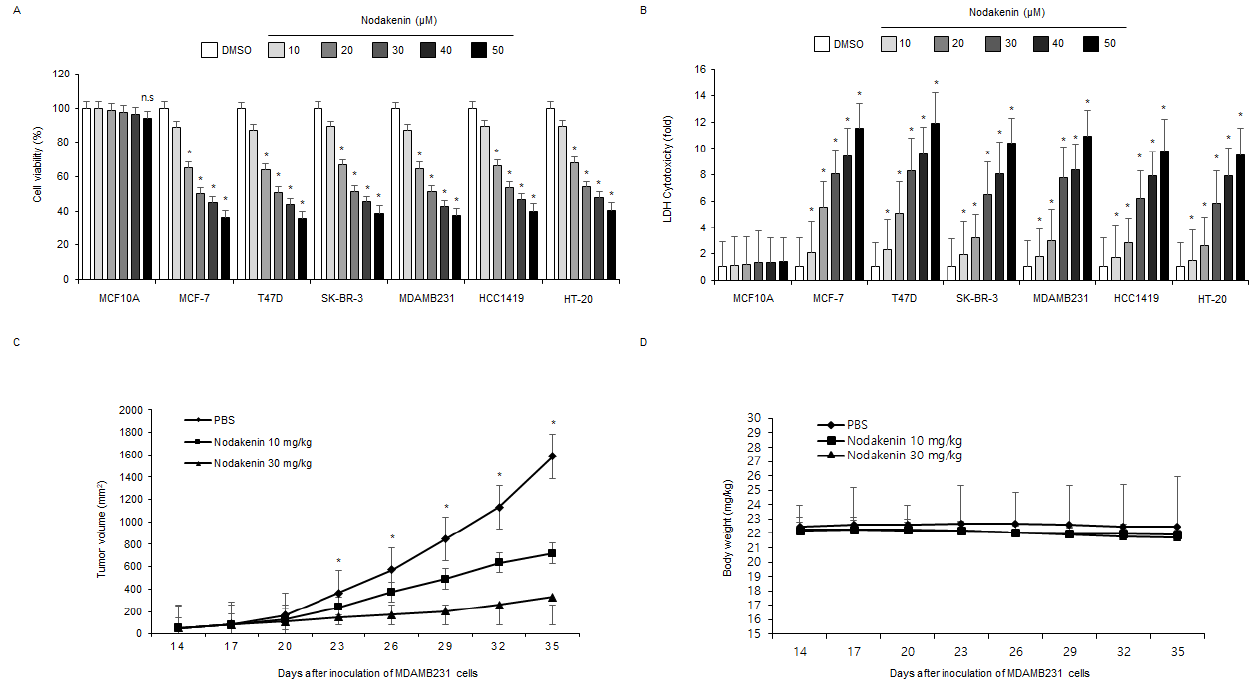
Figure 1. Anti-tumor effects of nodakenin in various breast cancer cell types and xenograft models. ( A , B ) Cell viability and LDH cytotoxicity were determined using the WST-1 assay and LDH cyto- toxicity assay in a dose-dependent manner in nodakenin-induced normal breast and breast cancer cells (MCF10A, MCF-7, T47D, SK-BR-3, MDAMB231, HCC1419, and HT-20); * p < 0.05. n.s., not sig- nificant. ( C , D ) 1 × 10 7 MDAMB231 cells were injected (sc) into the right dorsal flank of nude mice (n = 10/group). Nodakenin (10 or 30 mg/kg) was administered (ip) twice weekly. Body weights of the MDAMB231 tumor-xenograft mice were determined twice a week during the experiment.